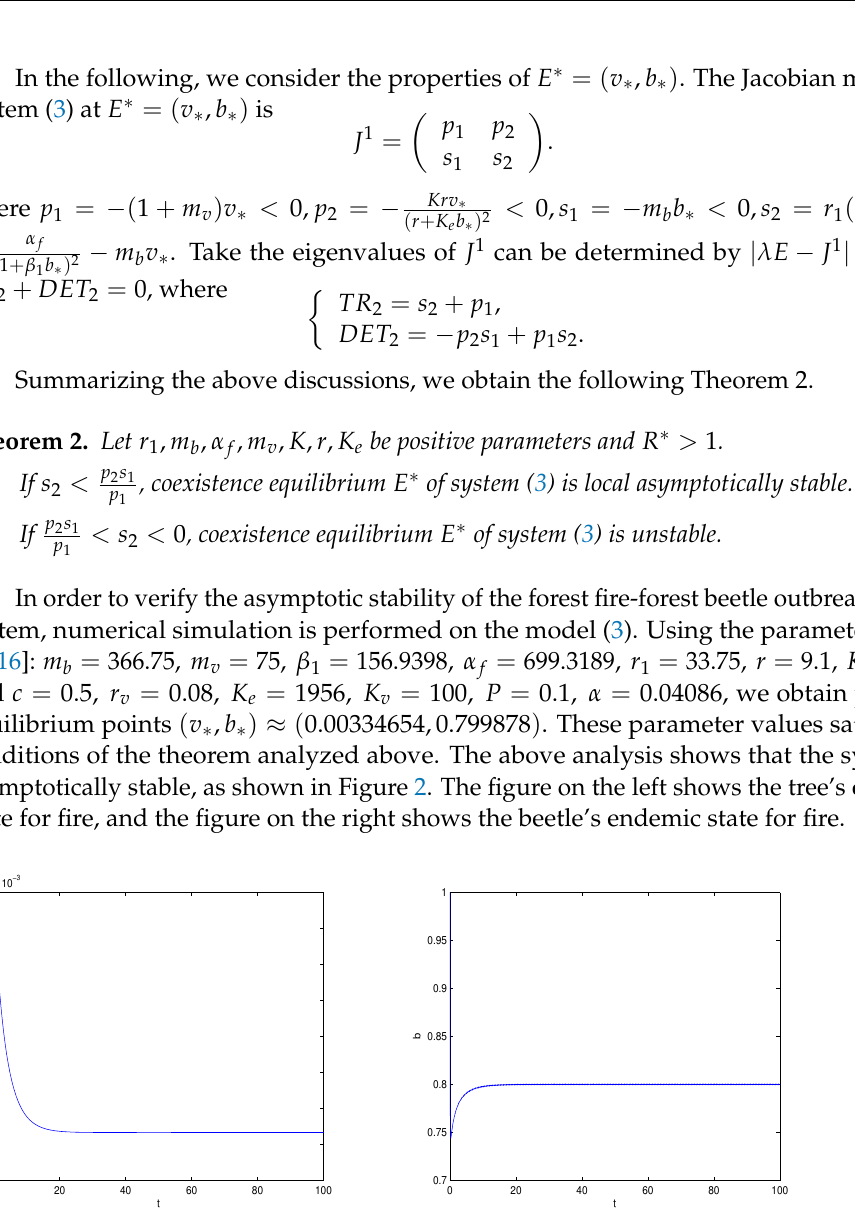
Figure 2. Tree’s and beetle’s endemic